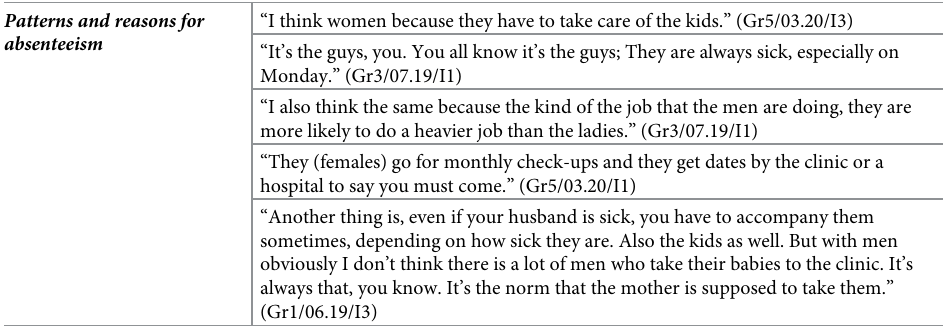
Table 3. Absenteeism in the workplace, sub-theme and illustrative quotes. Patterns and reasons for